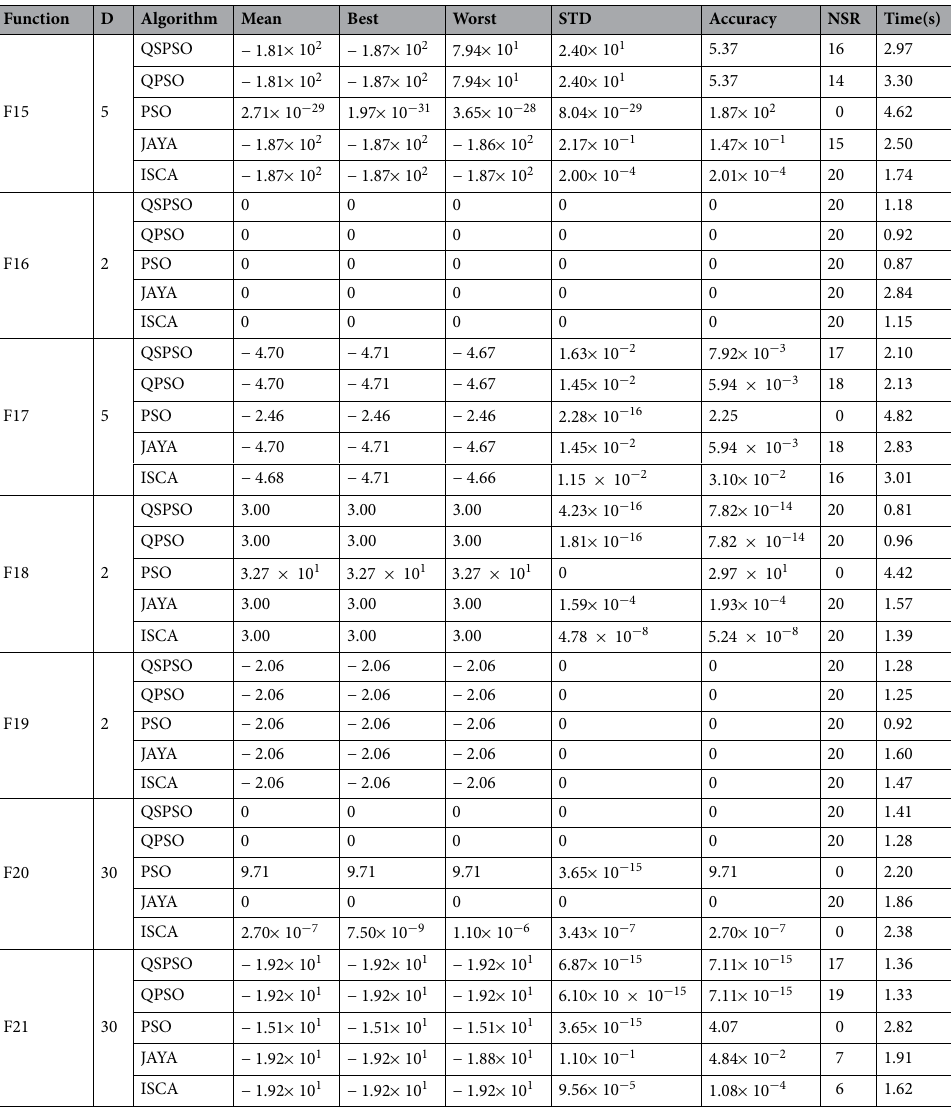
Table 4. Numerical results for fixed dimension multimodal benchmark